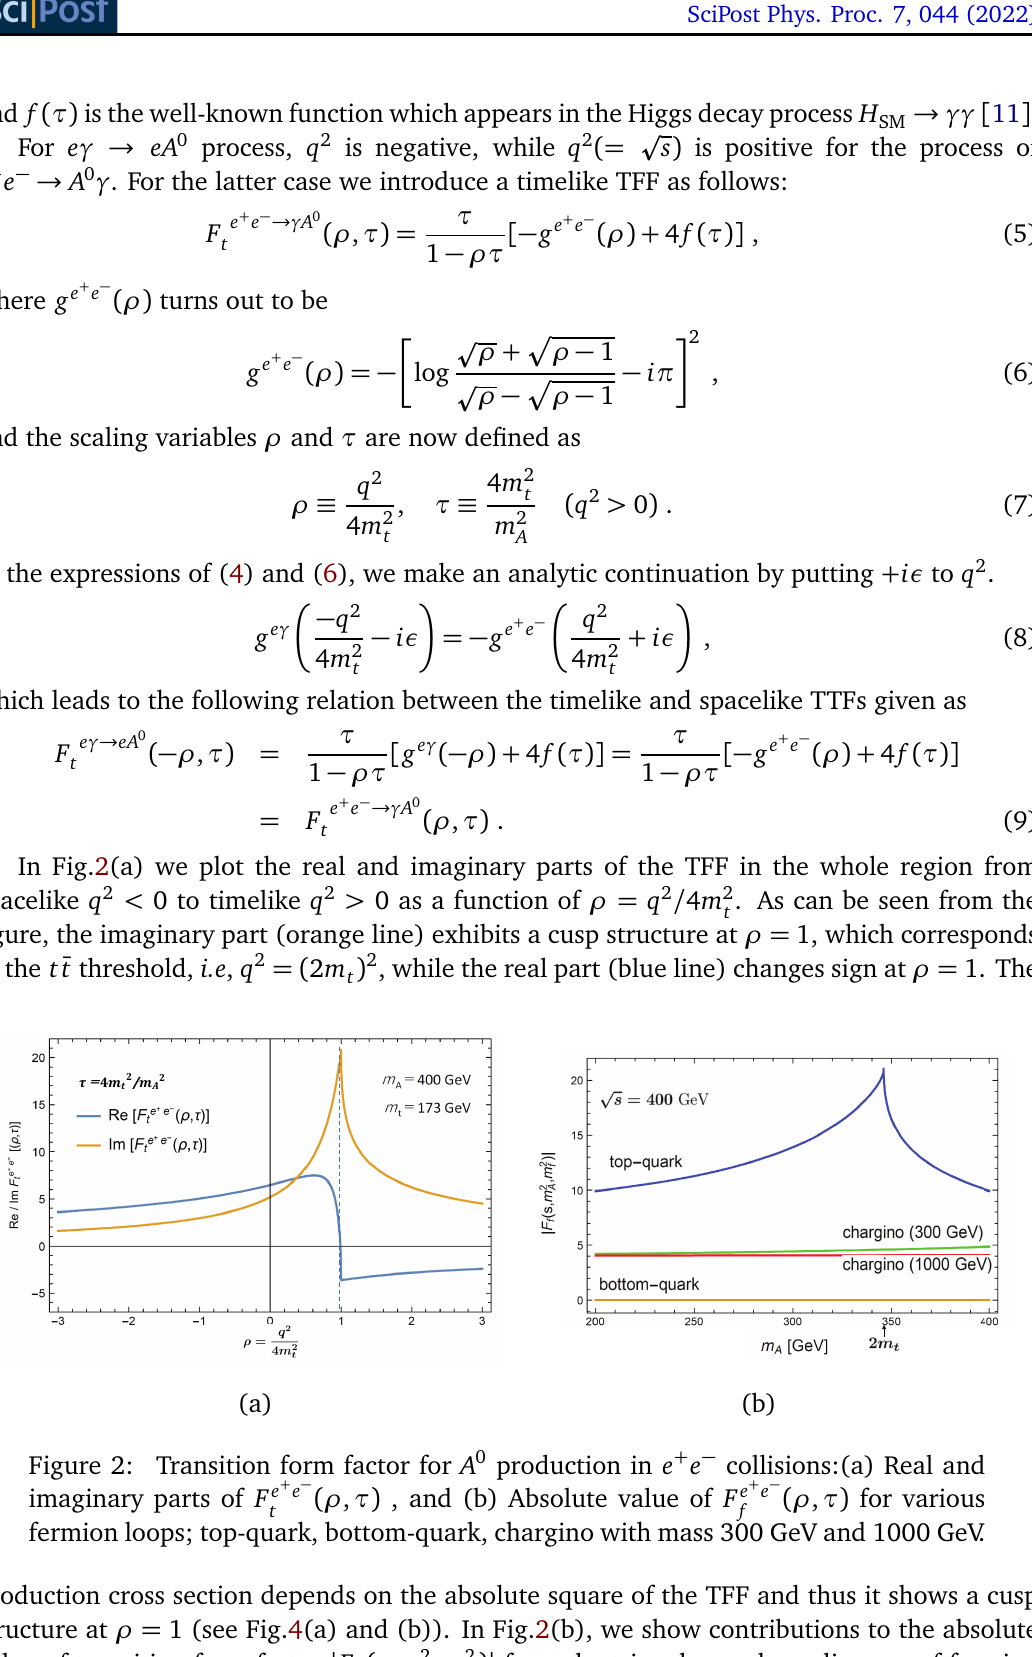
( ρ , τ ) for various f